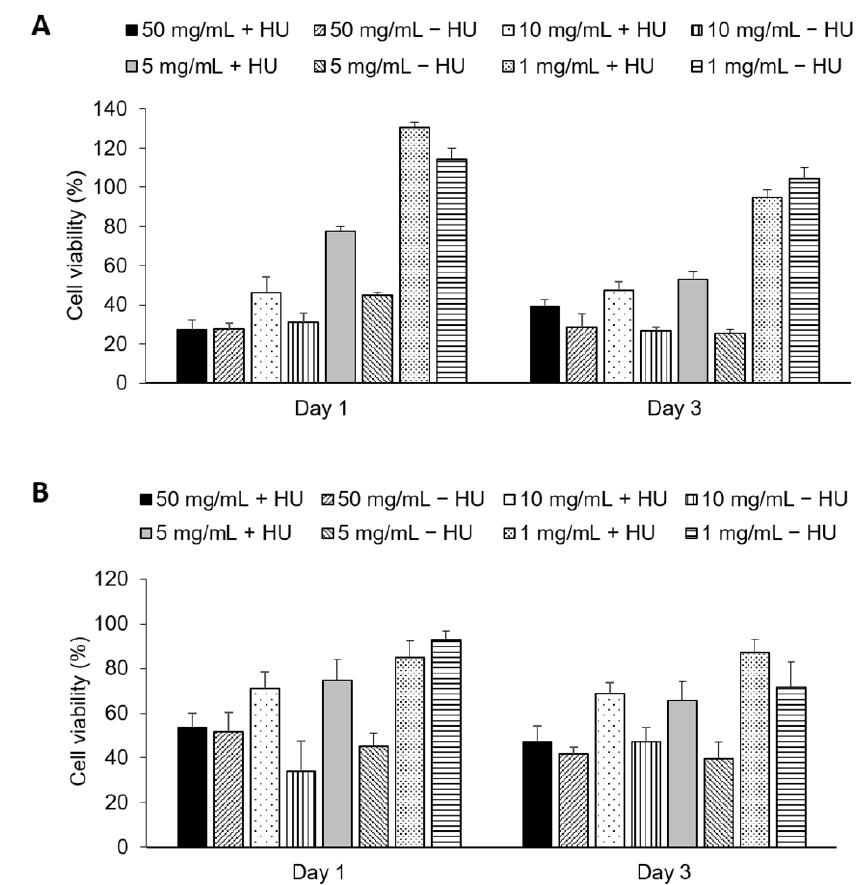
Figure 8. Cell viability after treating 20,000 cells/well ( A ) and 40,000 cells/well ( B ). The cells were treated with 50 mg/mL, 5 mg/mL, 10 mg/mL, and 1 mg/mL. For each concentration, particles with (+) and without ( − ) Hydroxyurea was tested. (Mean ± SD, n = 6). Cell Viability with Pre-Dissolved Drug Release The particles were pre-dissolved in 1 M hydrochloric acid, neutralized with 1 M sodium hydroxide, and diluted with DMEM/F12 media (1:10). Cells were treated with dissolved particles, with and without drug at two concentrations 2.5 mg/mL and 5 mg/mL. The dissolved particles containing HU had lower cell viability compared to the particles without HU, meaning that HU does have an effect on the cells and that the limiting step is the slow dissolution of particles (Figure